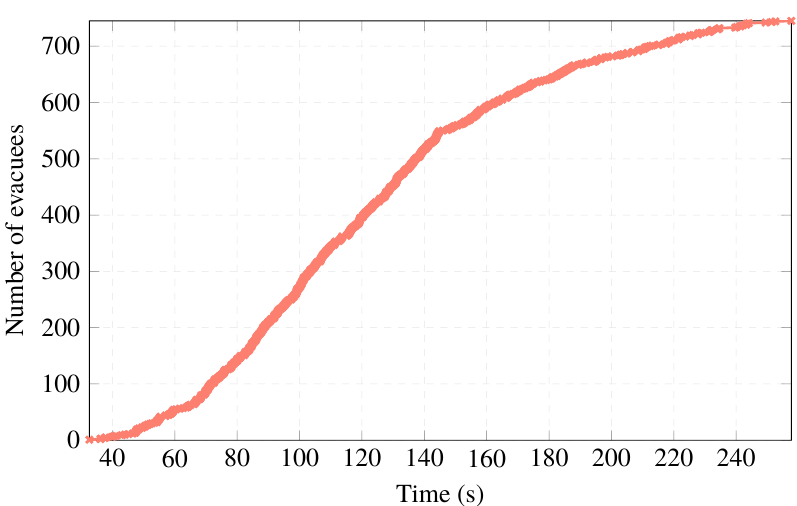
Figure 9. Dispersion diagram, abandonment time per number of evacuees (3 TW,